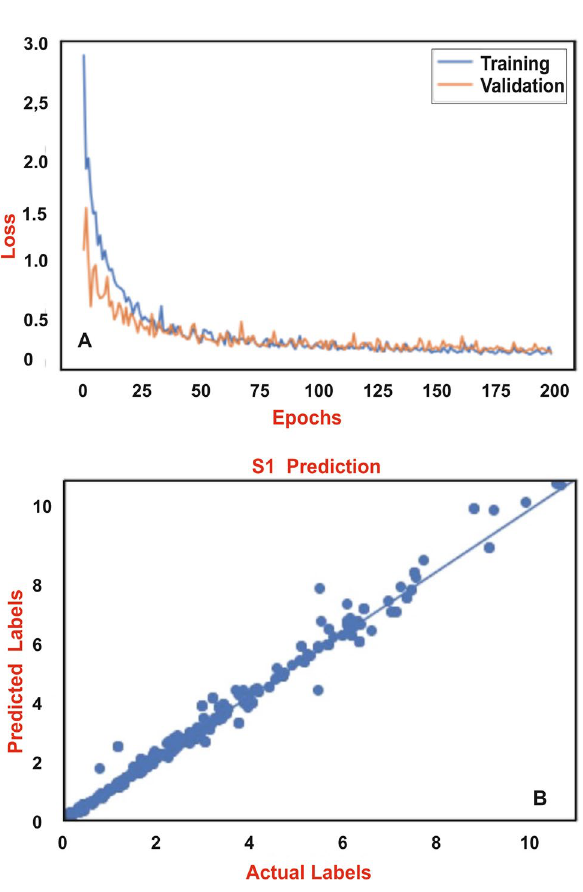
Figure 4. ( A ) The training and validation loss plot with 200 epochs, ( B ) Linear correlation coefficient plot of the real and predicted S1. R 2 is as high as